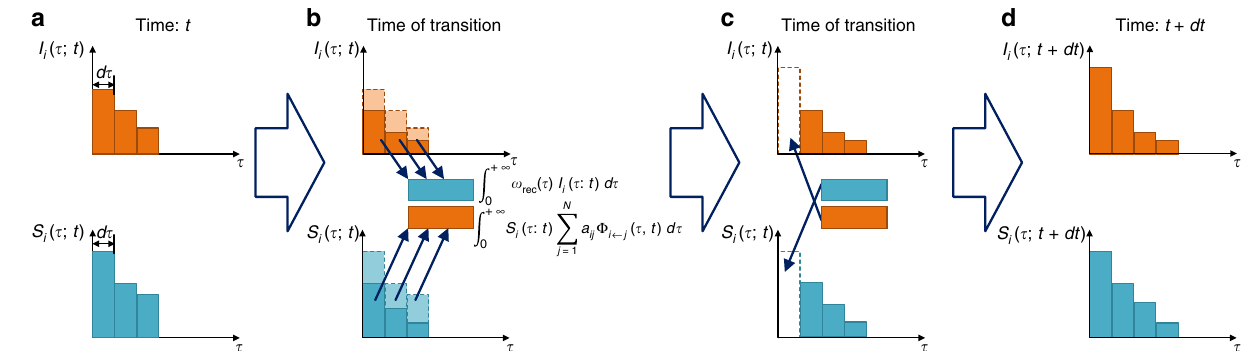
Fig. 2 Schematic representation of probability fl ows. Each illustration is divided into blocks of width d τ → 0, and the area of each block represents the probability that node i is in the corresponding state aged from τ to τ + d τ . a Two distributions, I i ( τ ; t ) and S i ( τ ; t ), of node i at time t . b Each block losses probability ω rec ( τ ) I i ( τ ; t )d τ or S i ð τ ; t Þ moves one step to the right, and the empty blocks S i (0; t + d t ) and I i (0; t + d t ) are fi lled with the probabilities